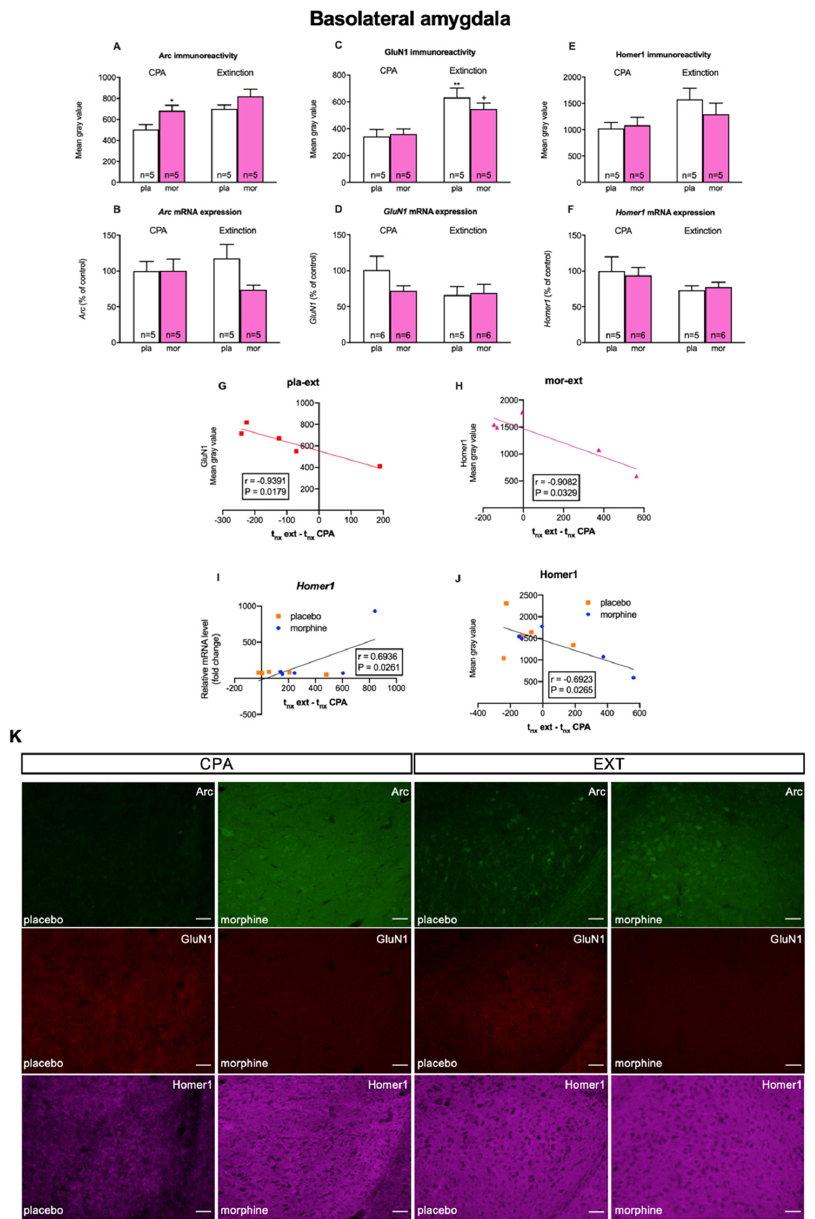
Figure 4. Basolateral amygdala: ( A , B ) Analysis of Arc immunoreactivity and mRNA expression during CPA and extinction test. ( C , D ). Analysis of GluN1 immunoreactivity and mRNA expression during CPA and extinction test. ( E , F ). Analysis of Homer1 immunoreactivity and mRNA expression during CPA and extinction test. ( G ) Correlation between GluN1 immunoreactivity and the difference between the time spent in the naloxone chamber during extinction test and CPA test in placebo rats that underwent extinction protocol. ( H ) Correlation between Homer1 immunoreactivity and the difference between the time spent in the naloxone chamber during extinction test and CPA test in morphine-treated rats that underwent the extinction protocol. ( I ) Correlation between relative Homer1 mRNA expression and the difference between the time spent in the naloxone chamber during extinction test and CPA test in placebo and morphine-treated rats that underwent extinction protocol. ( J ) Correlation between Homer1 immunoreactivity and the difference between the time spent in the naloxone chamber during extinction test and CPA test in placebo and morphine-treated rats that underwent extinction protocol. ( K ) Representative epifluorescence images showing triple immunostaining of Arc (green), GluN1 (red), and Homer1 (pink) during CPA and extinction test. * p < 0.05, ** p < 0.01 vs. P-CPA; + p < 0.05 vs. M-CPA. Each bar corresponds to mean ±